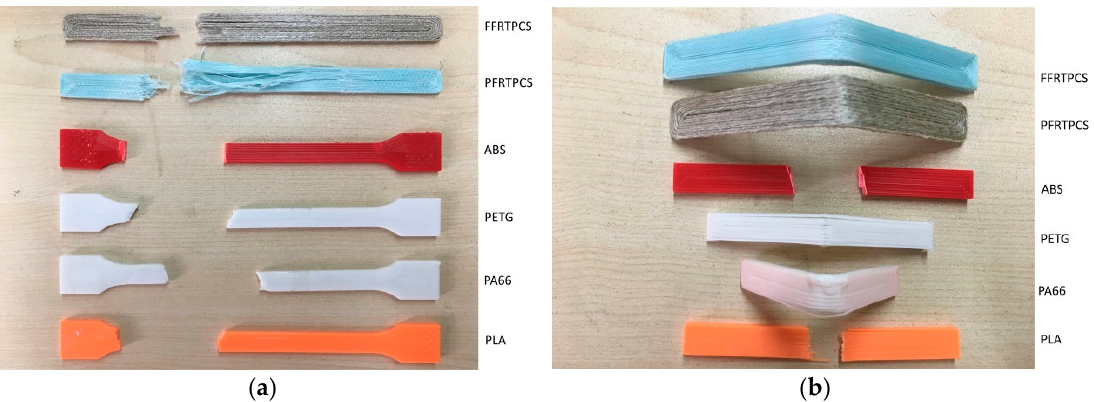
Figure 7. Fractured printed test specimens. ( a ) Specimens after the tensile test. ( b ) Specimens after the flexural test.